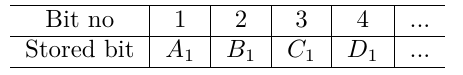
Table 1: Bit allocation for block-wise bit-slicing